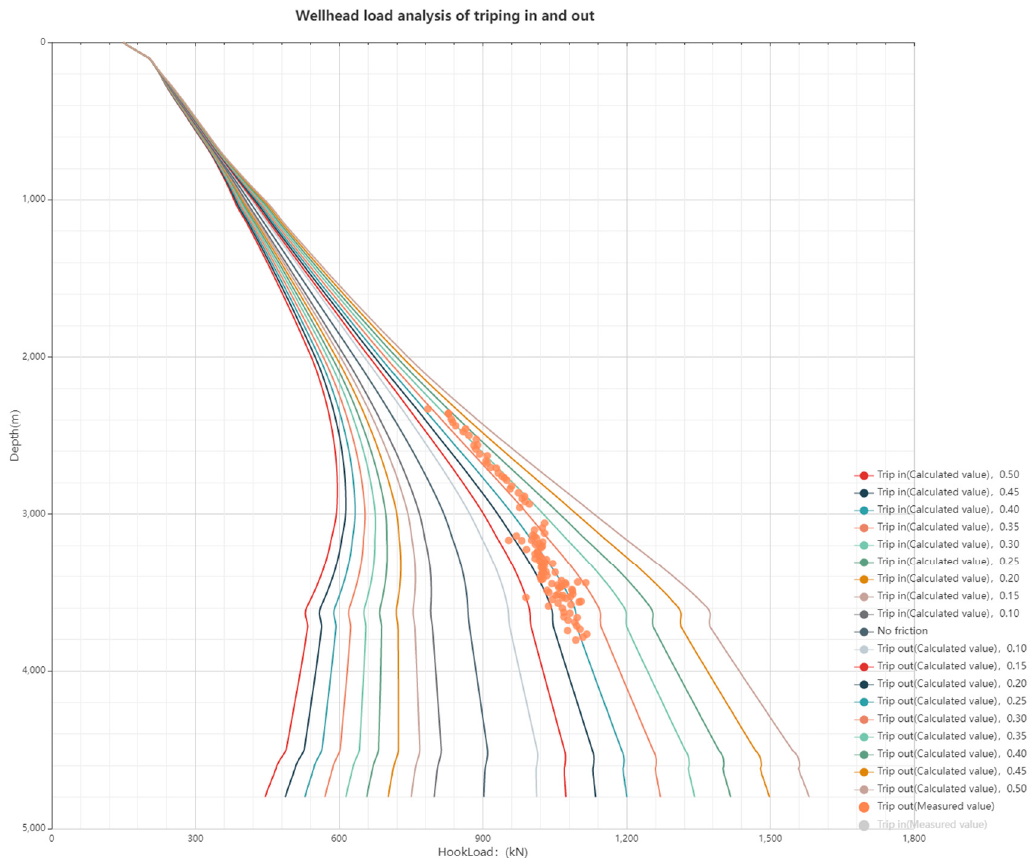
Figure 2. Distribution of calculated hookload and measured POOH value for well M.